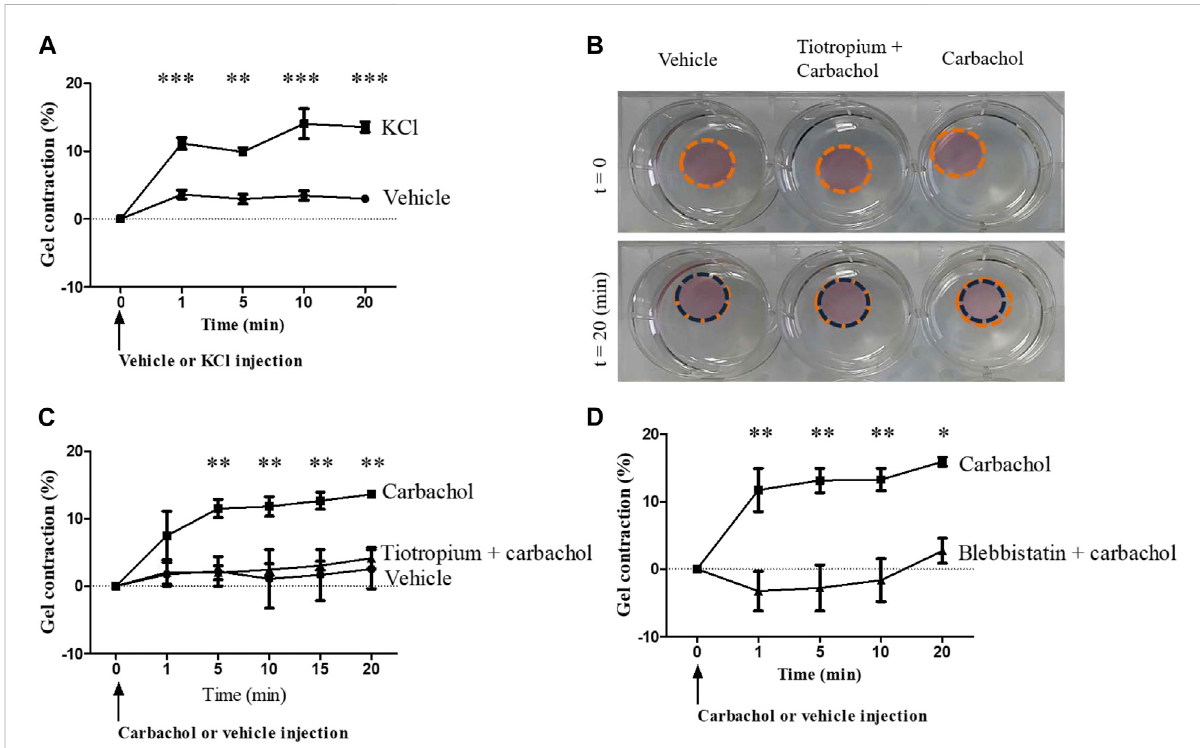
FIGURE 3 Muscarinic M3 receptor activation promotes COPD fi brocytes contraction. (A) . Signi fi cant contraction of fi brocytes-embedded collagen gels stimulated with KCl 80 mM (squares) compared to control vehicle (circles). Percentage of gel contraction is presented against time. (B) . Aspect of fi brocytes-embedded collagen gels stimulated with control vehicle or with carbachol 10 − 4 M, with or without prior tiotropium bromide 10 − 6 M addition,beforeand20 minafterthebeginningoftheexperiment. (C) .Signi fi cantcontractionof fi brocytes-embeddedcollagengelsstimulated with carbachol 10 − 4 M (squares) compared to control vehicle (circles) or tiotropium bromide 10 − 6 M + carbachol 10 − 4 M (triangles). (D) . Signi fi cant inhibition of carbachol-induced gel contraction (squares) when incubating collagen gels with blebbistatin 10 µM prior to carbachol stimulation (triangles). Signi fi cant difference * p < 0.05, ** p < 0.01, *** p < 0.001, otherwise no signi fi cant